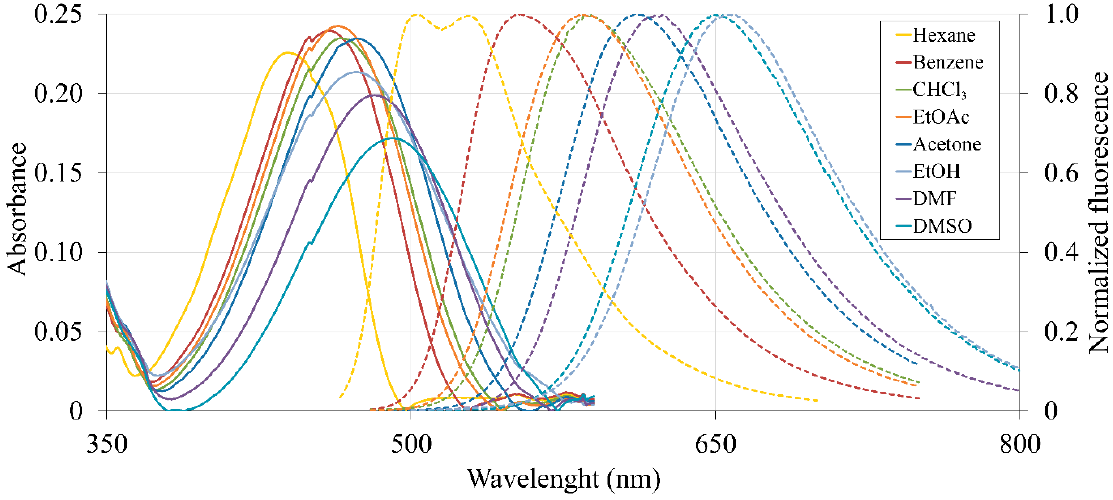
Figure 1. The UV-Vis absorption and fluorescence emission (dashed lines) spectra of amidine 2 in various organic solvents (concentration is 1 × 10 − 5 mol L − 1 ).